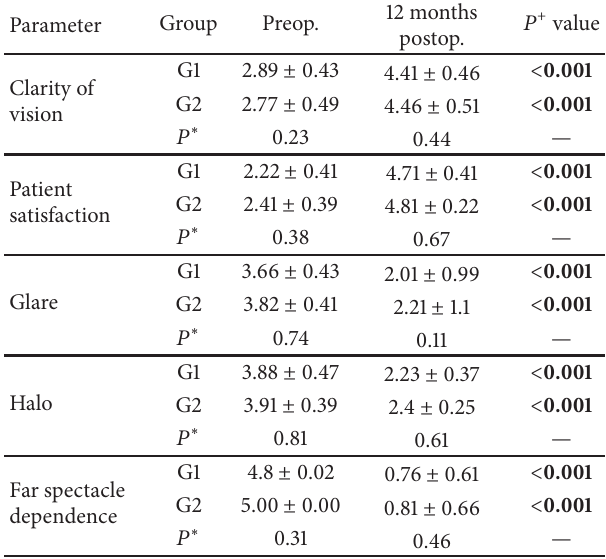
𝑃 + : paired 𝑡 -test for comparison between preoperative and postoperative values of the same group. 𝑃 ∗ : unpaired 𝑡 -test for comparison between the 2 groups. Significant 𝑃 values are